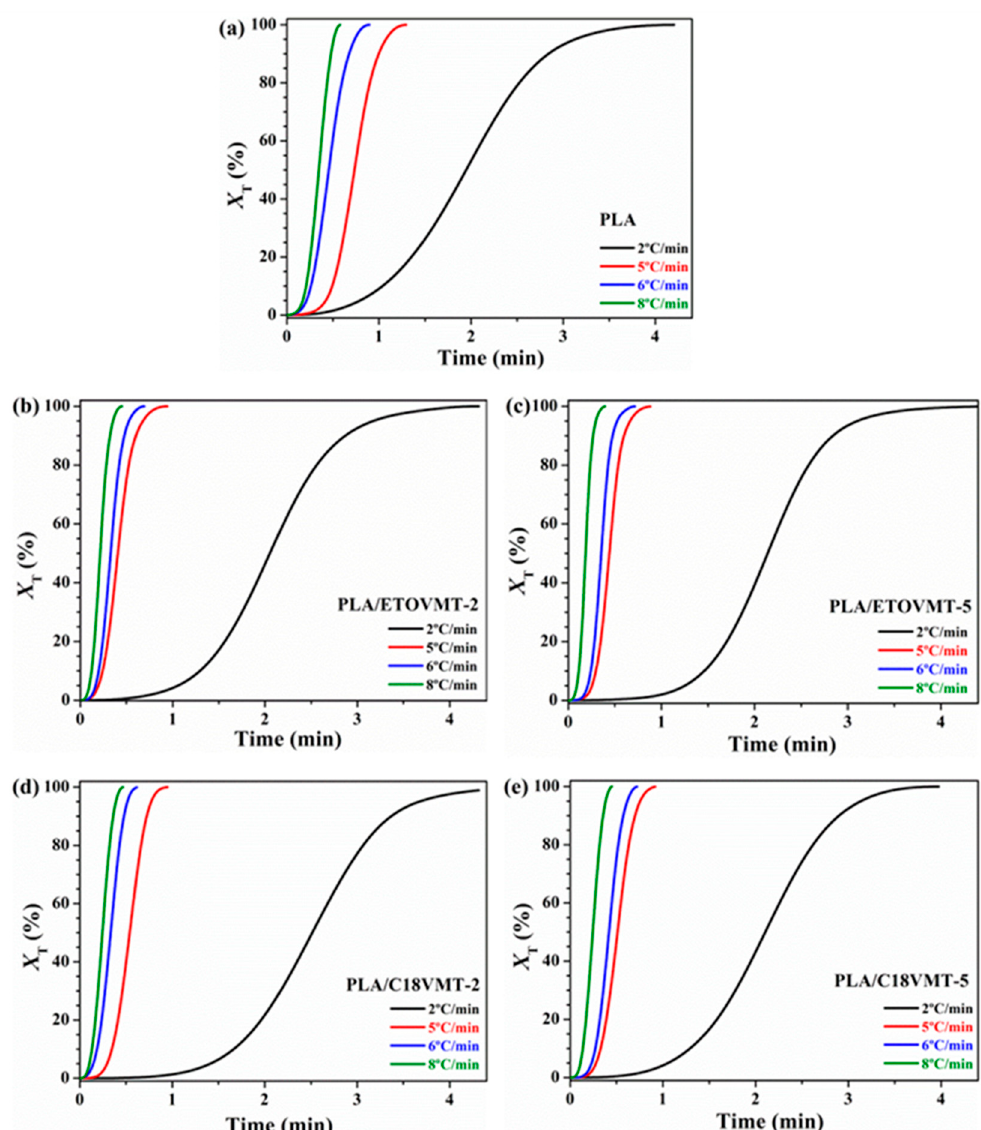
Figure 6. Relative crystallinity as a function of time at different heating rates for the cold crystallization of ( a ) PLA, ( b ) PLA/ETOVMT-2, ( c ) PLA/ETOVMT-5, ( d ) PLA/C18VMT-2, ( e ) PLA/C18VMT-5.